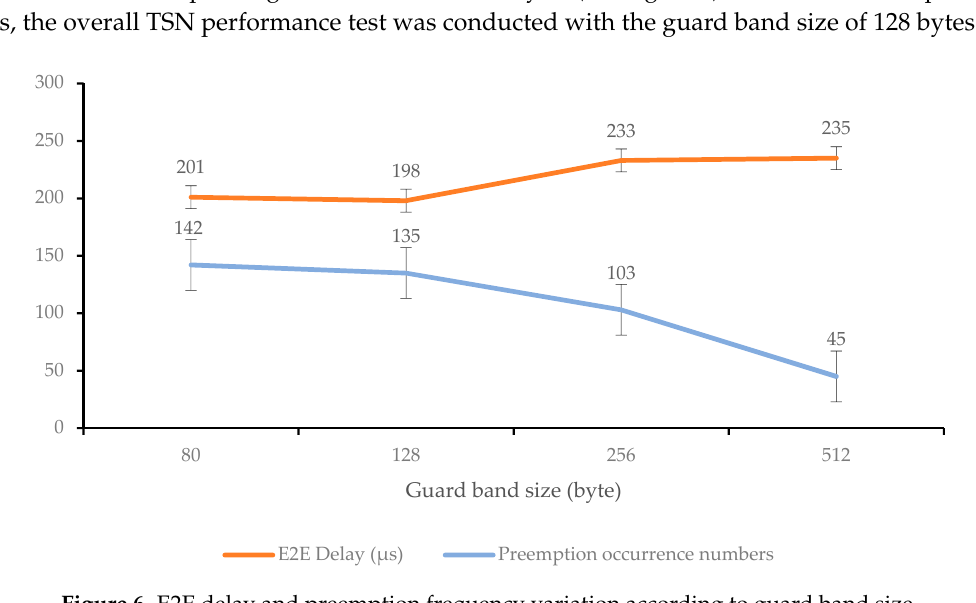
Figure 6. E2E delay and preemption frequency variation according to guard band size.